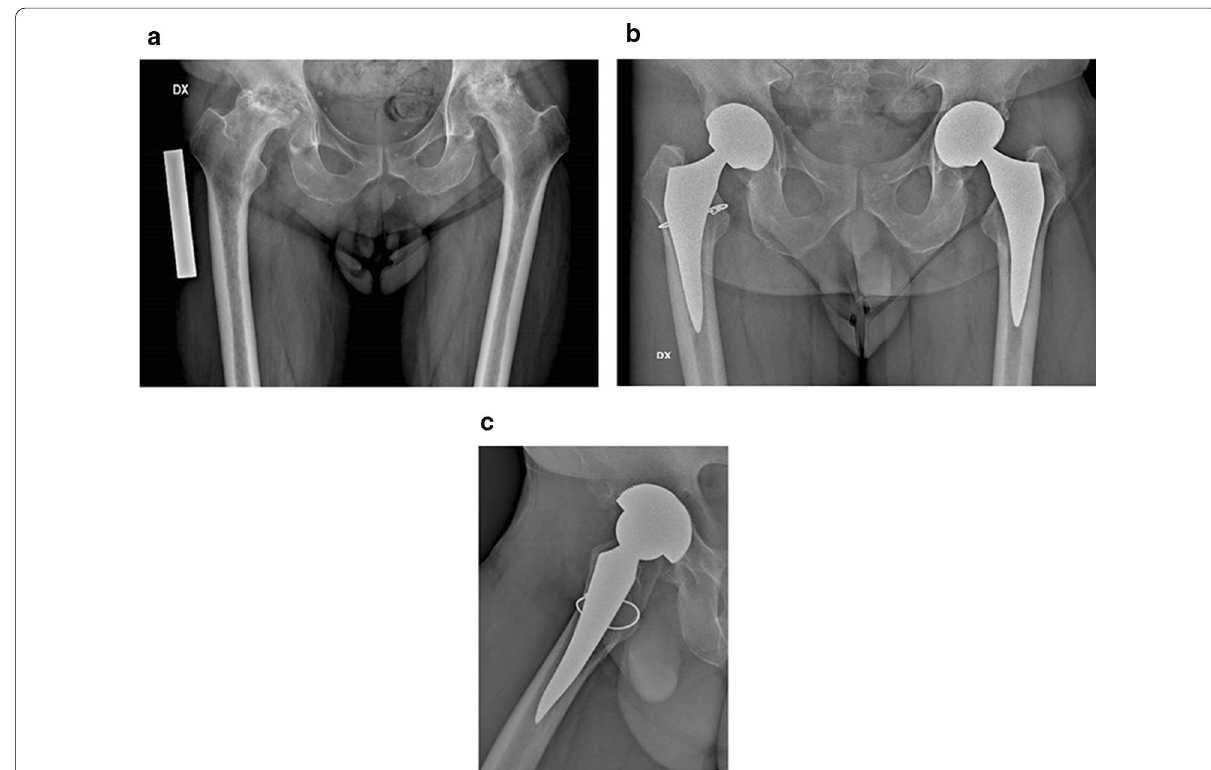
Fig. 2 Bilateral avascular necrosis of femoral head in a 46-year-old patient ( a ). Five years radiographic follow-up: anteroposterior view ( b ) and axial view of right ( c ) and left ( d ) hips. Undisplaced fracture of calcar region treated with preventive cerclage on right hip